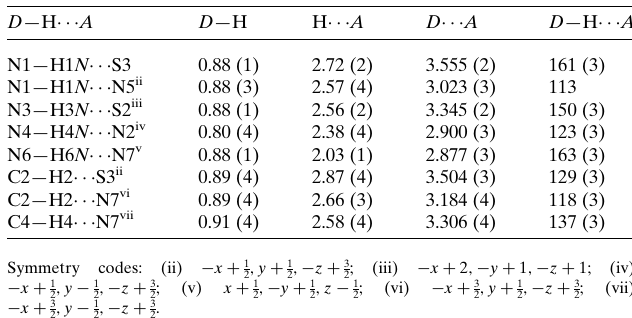
Table 2 Hydrogen-bond geometry (A˚ , (cid:3)